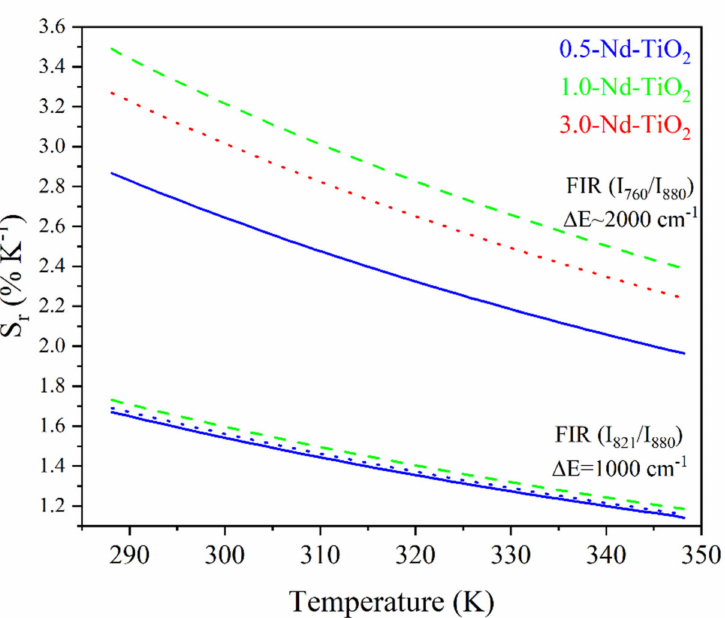
Figure 8. Relative thermal sensitivity values for x -Nd–TiO 2 ( x = 0.5, 1.0 and 3.0 wt.%) nanoparticles. The I 821 FIR and I 760 FIR are represented as solid blue, for x = 0.5, dash green, for x = 1.0 and dot red I 880 I 880 lines, for x = 3.0